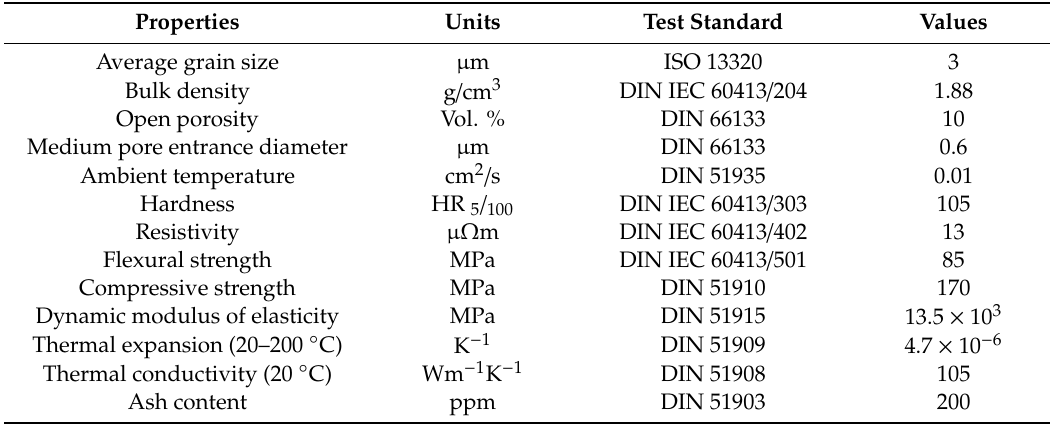
Table A1. Graphite electrode parameters.